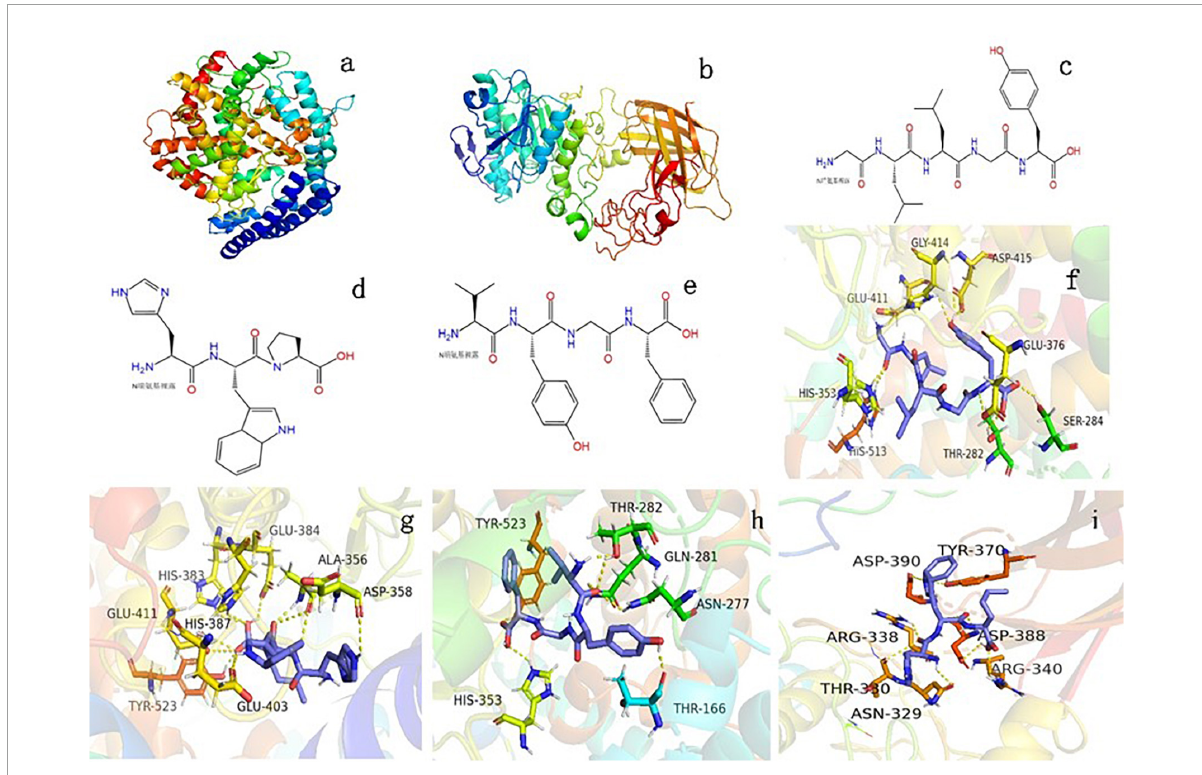
FIGURE2 Binding of oligopeptides to human ACE and porcine pancreatic lipase. Three-dimensional structures of (a) human ACE and (b) porcine pancreatic lipase. Structural diagrams of (c) GLLGY peptide, (d) HWP peptide, and (e) VYGF peptide. A visual interaction diagram of (f) GLLGY, (g) HWP, and (h) VYGF with ACE. (i) A visual interaction diagram of HWP with pancreatic lipase. The yellow dotted lines indicate hydrogen